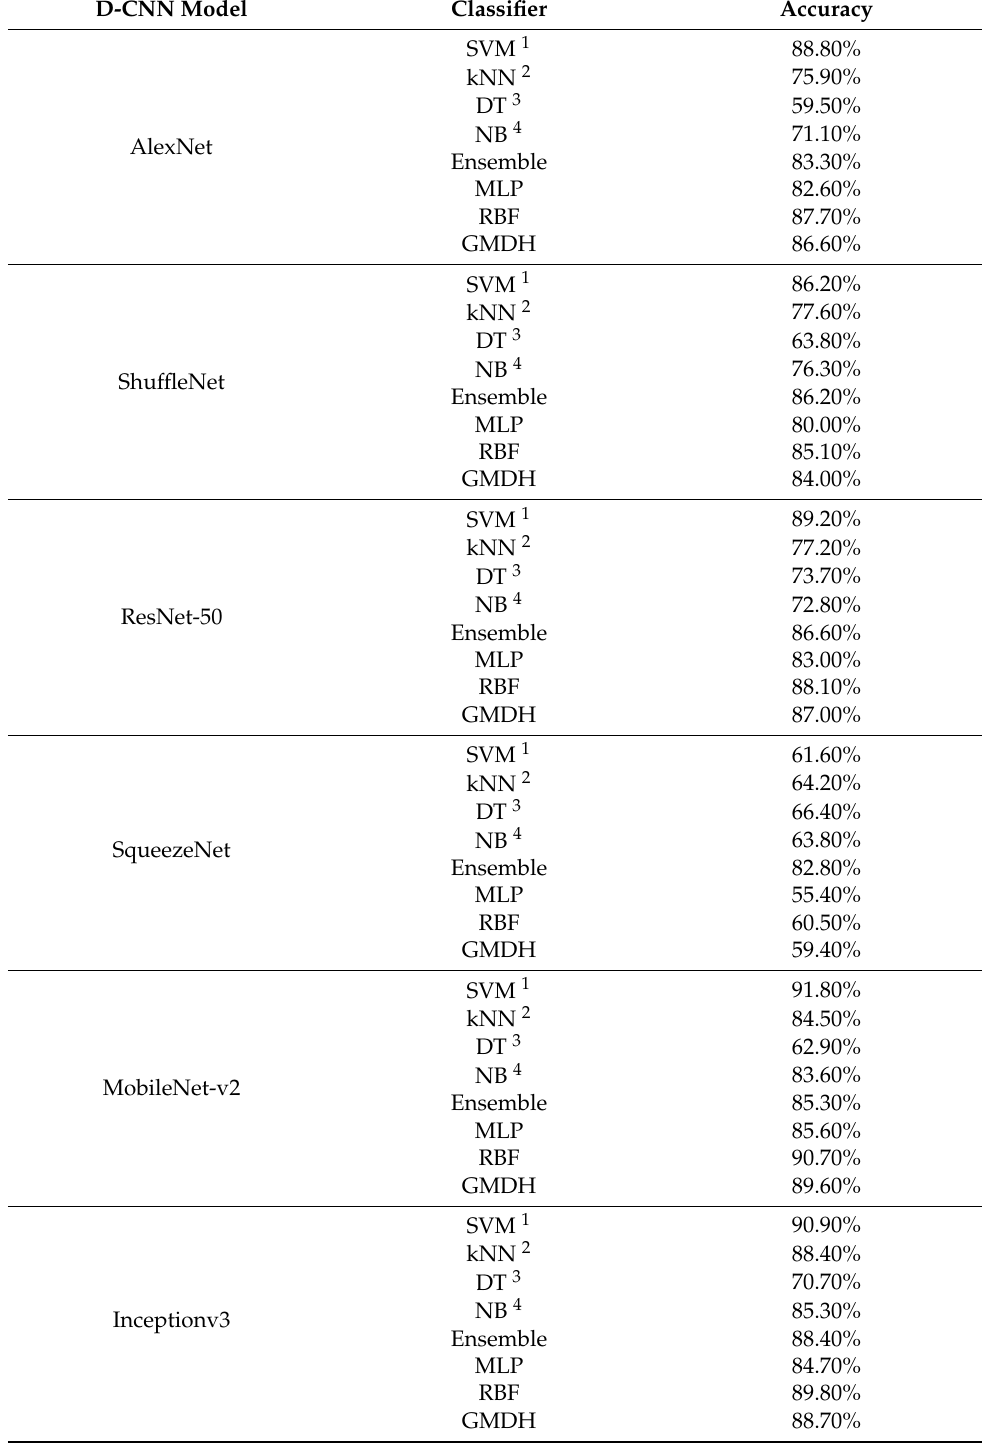
Table 3. Performance values in terms of accuracy obtained from different D-CNN